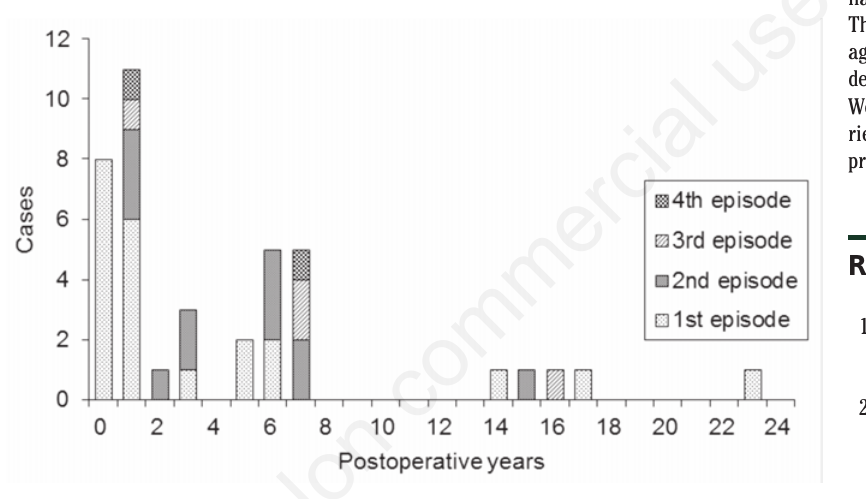
Figure 1. Timing of the appearance of postoperative intestinal obstruction. Table 3. Correlations between clinical factors and postoperative intestinal obstruction. Clinical factors